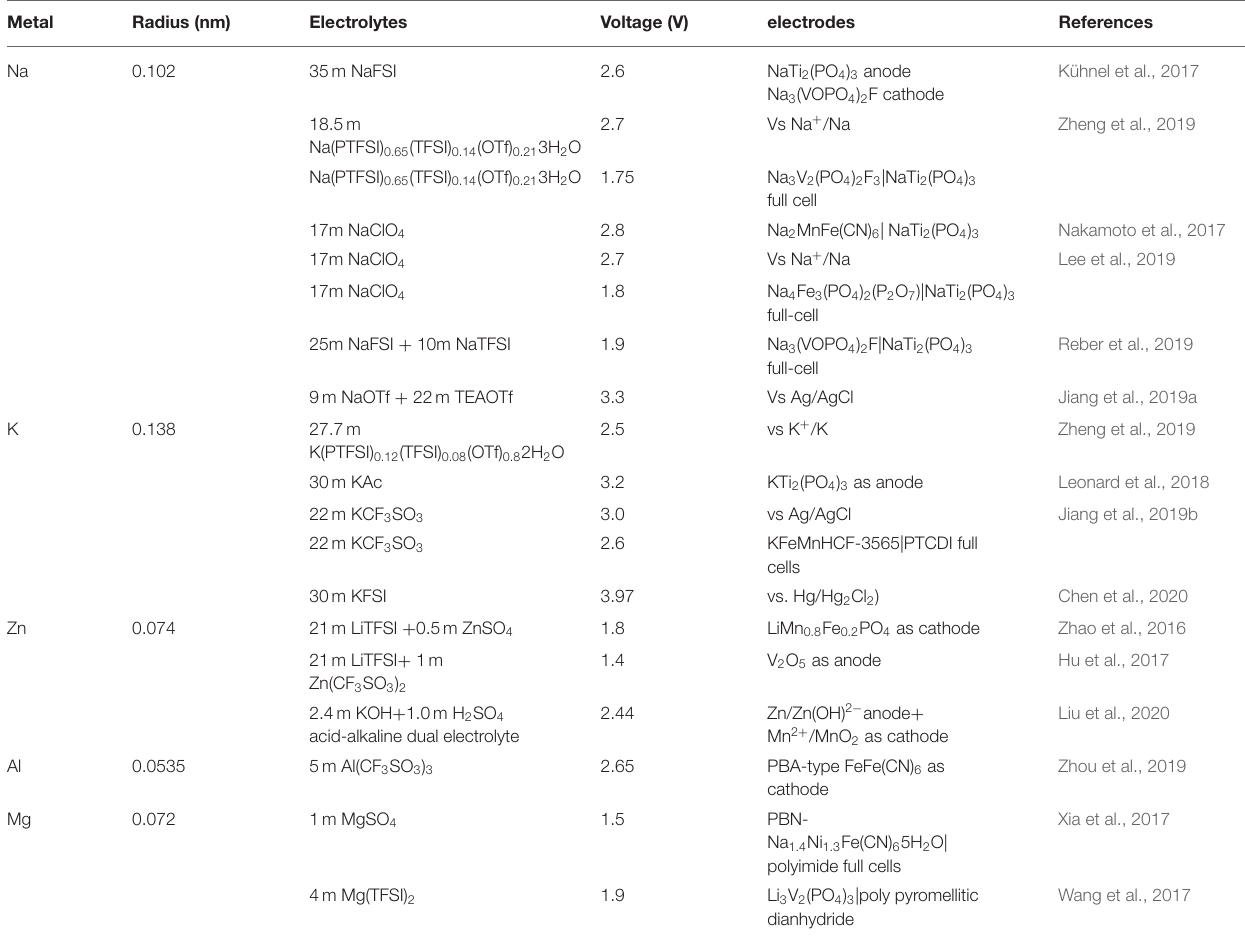
TABLE 1 | The main electrochemical properties for WIS-based aqueous non-lithium batteries.